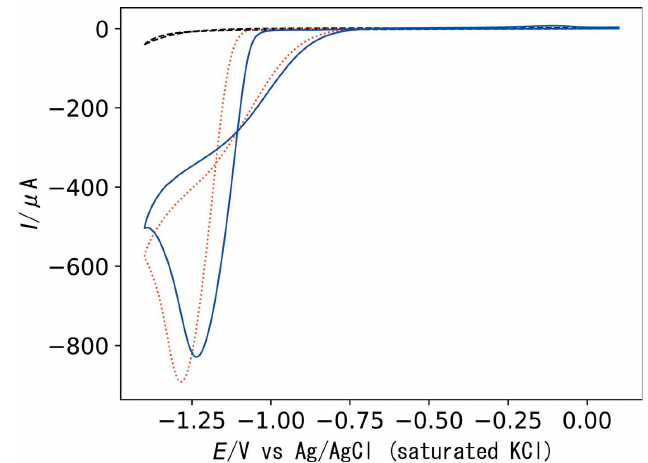
Figure 5 Cyclic voltammograms of complexes 1 (0.5 m M , red dotted line), 2 (0.5 m M , blue solid line), and 3 (0.5 m M , black dashed line) in water containing 0.10 M KNO 3 : scan rate, 0.1 V s (cid:5) 1 ; working electrode, glassy carbon; auxiliary electrode, platinum wire; reference electrode, Ag/AgCl/ saturated KCl.